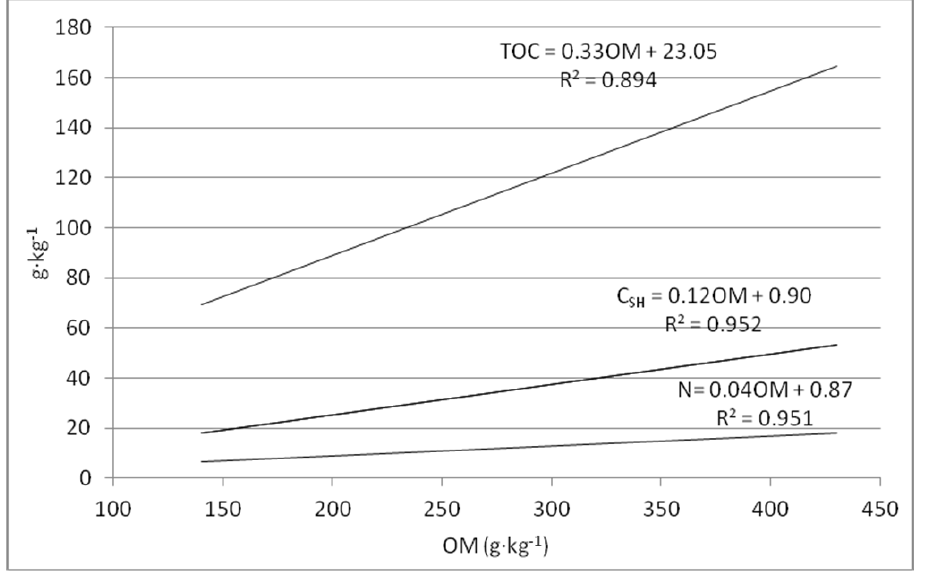
Figure 8. Linear regression for organic matter (OM) and humic substances (C SH ), N and total organic carbon (TOC) in composts.